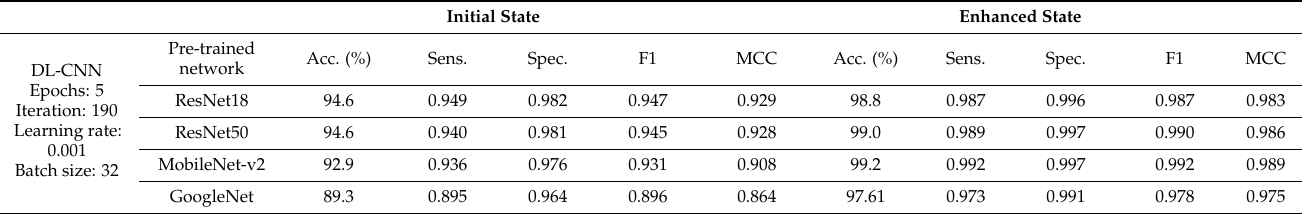
Table 11. HAR performance metrics in local PD dataset.